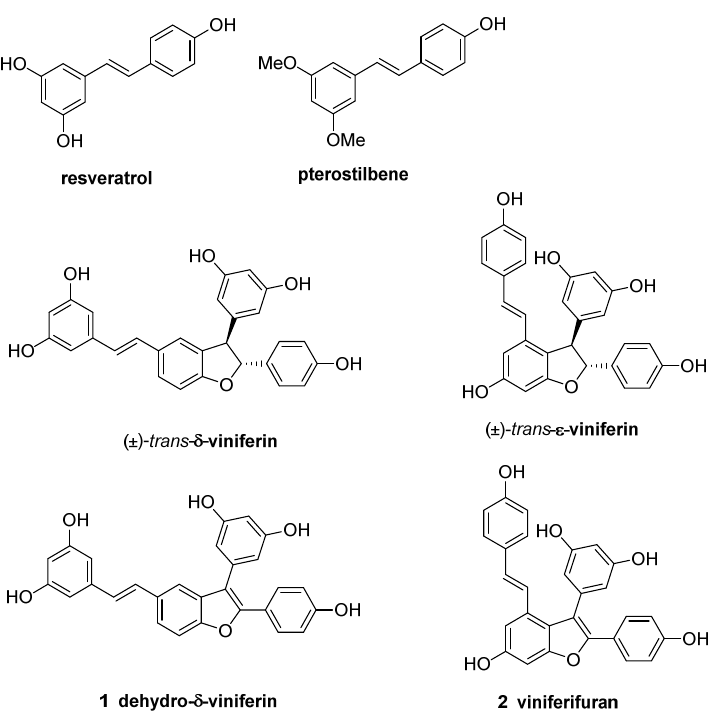
Figure 1. Structures of resveratrol and representative resveratrol-derived monomers and dimers.